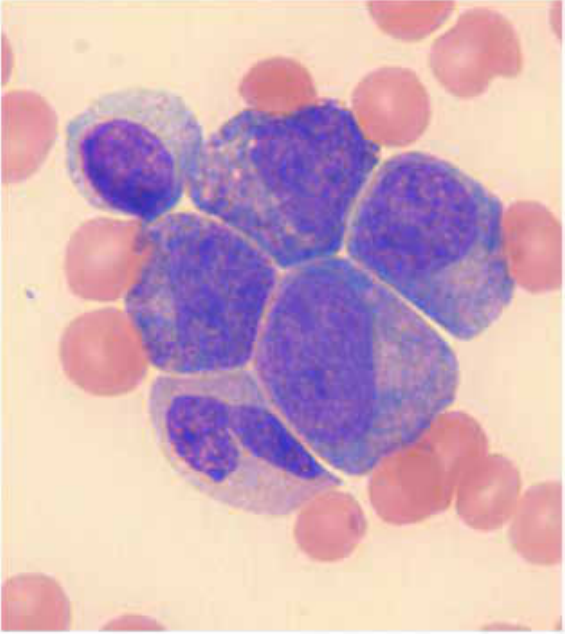
Figure 2: Peripheral blood smear of the patient at at high (100 x) magnification showing a blast, promyelocyte, an eosinophil precursor, band cell and